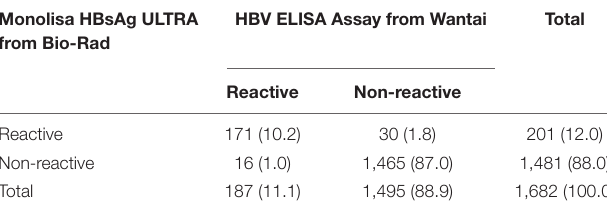
TABLE 1 | Seroprevalence of hepatitis B virus infections of Li ethnic. Monolisa HBsAg ULTRA from Bio-Rad